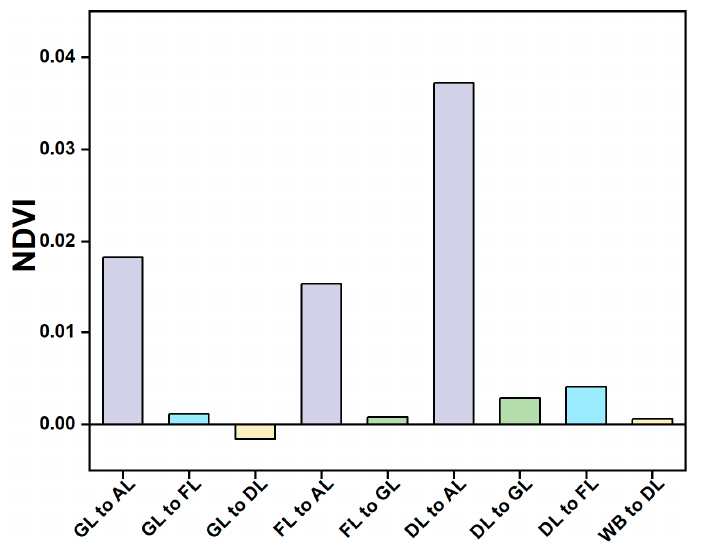
Figure 11. Effects of land use transfer types on the spatial variation of NDVI in CA from 1982 to 2017. (AL represents arable land, GL represents grassland, FL represents forestland, PDL represents potential desert land, CL represents construction land, DL represents desert land, WB represents water body, and Others represents other land types).